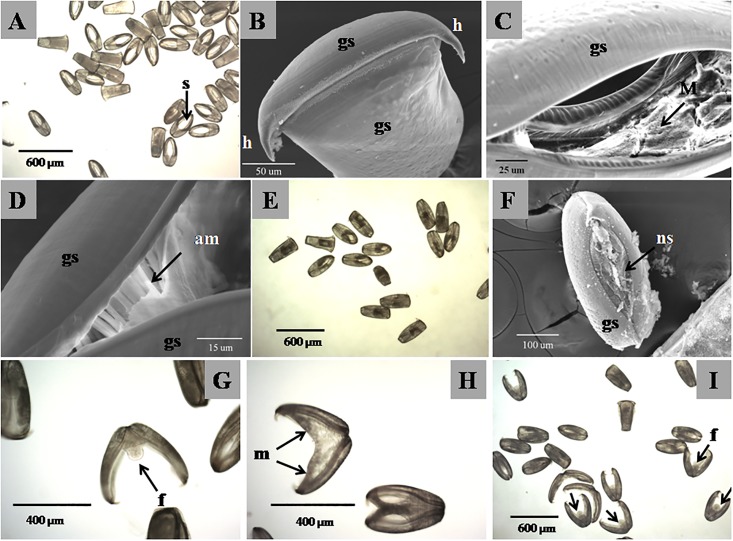
Comparison of metamorphosis of glochidia of pink heelsplitter in two different vitro culture methods.ns, new shell; gs, glochidial shell; s, space; f, foot; h, hook; m, mantle; am, adductor muscle.